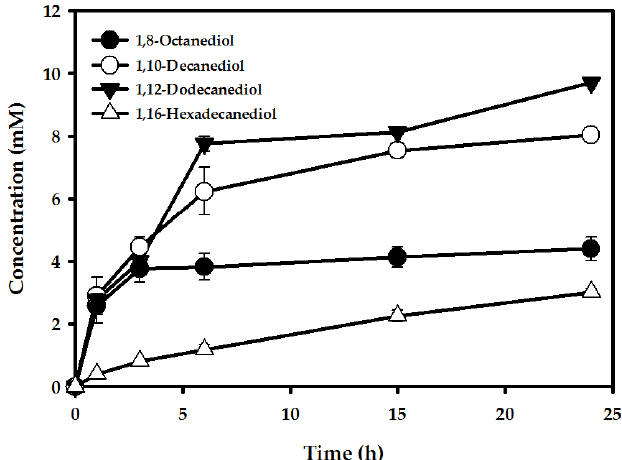
Figure 2. In vivo production of α , ω‐ diols using E. coli BW25113 ( ∆ fadD, DE3) cells expressing MmCAR and Sfp. Reaction Conditions: Substrate, 10 mM ω‐ OHFAs (C 8 –C 16 ); Volume, 10 mL in 100 mL flask; Temp, 30 °C; Buffer, 100 mM potassium phosphate buffer (pH: 7.5) with 1% glucose ( w / v ) and 10 mM MgCl 2 ; Cell OD 600 , 30.